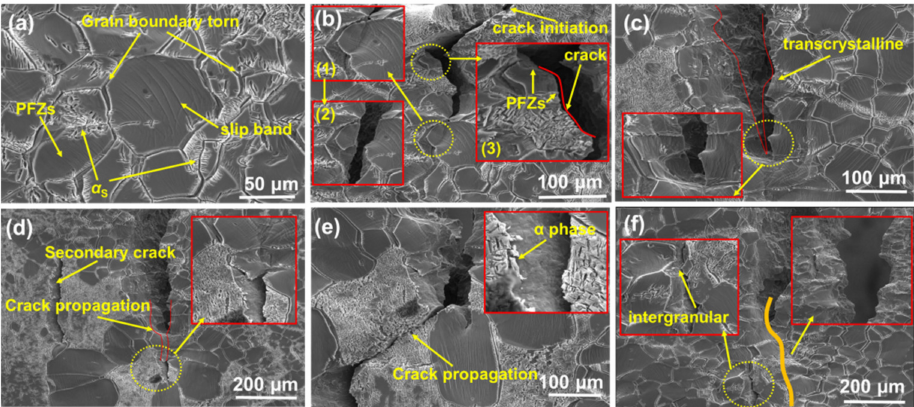
Figure 11. In situ tensile testing process of SA alloy ( a ) ε = 0.10, ( b ) ε = 0.26, ( c ) ε = 0.34, ( d ) ε = 0.41, ( e ) ε = 0.53, ( f ) ε =